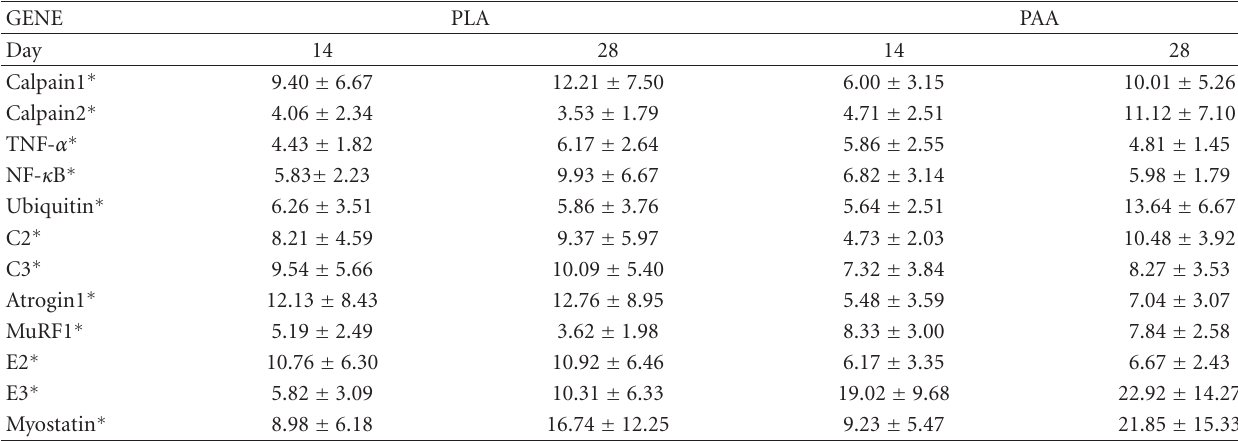
Table 5: Fold changes from baseline for all genes of interest for placebo (PLA) and protein/amino acid (PAA) groups. All genes of interest showed significant increases over time ( P < . 05), but there was no di ff erence noted between supplement groups. ∗ Denotes a significant time e ff